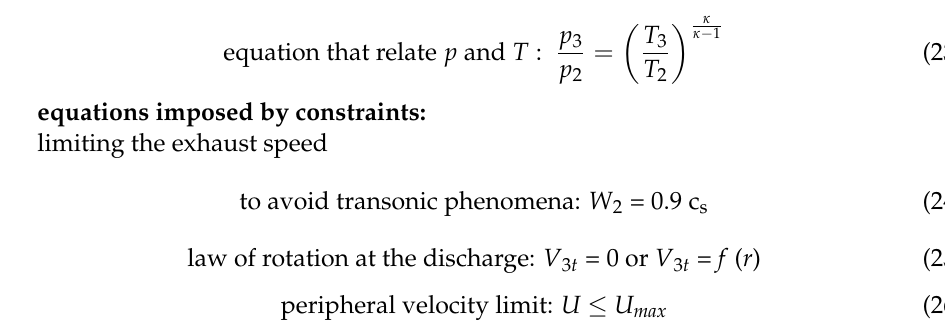
Figure 7. Baines chart.